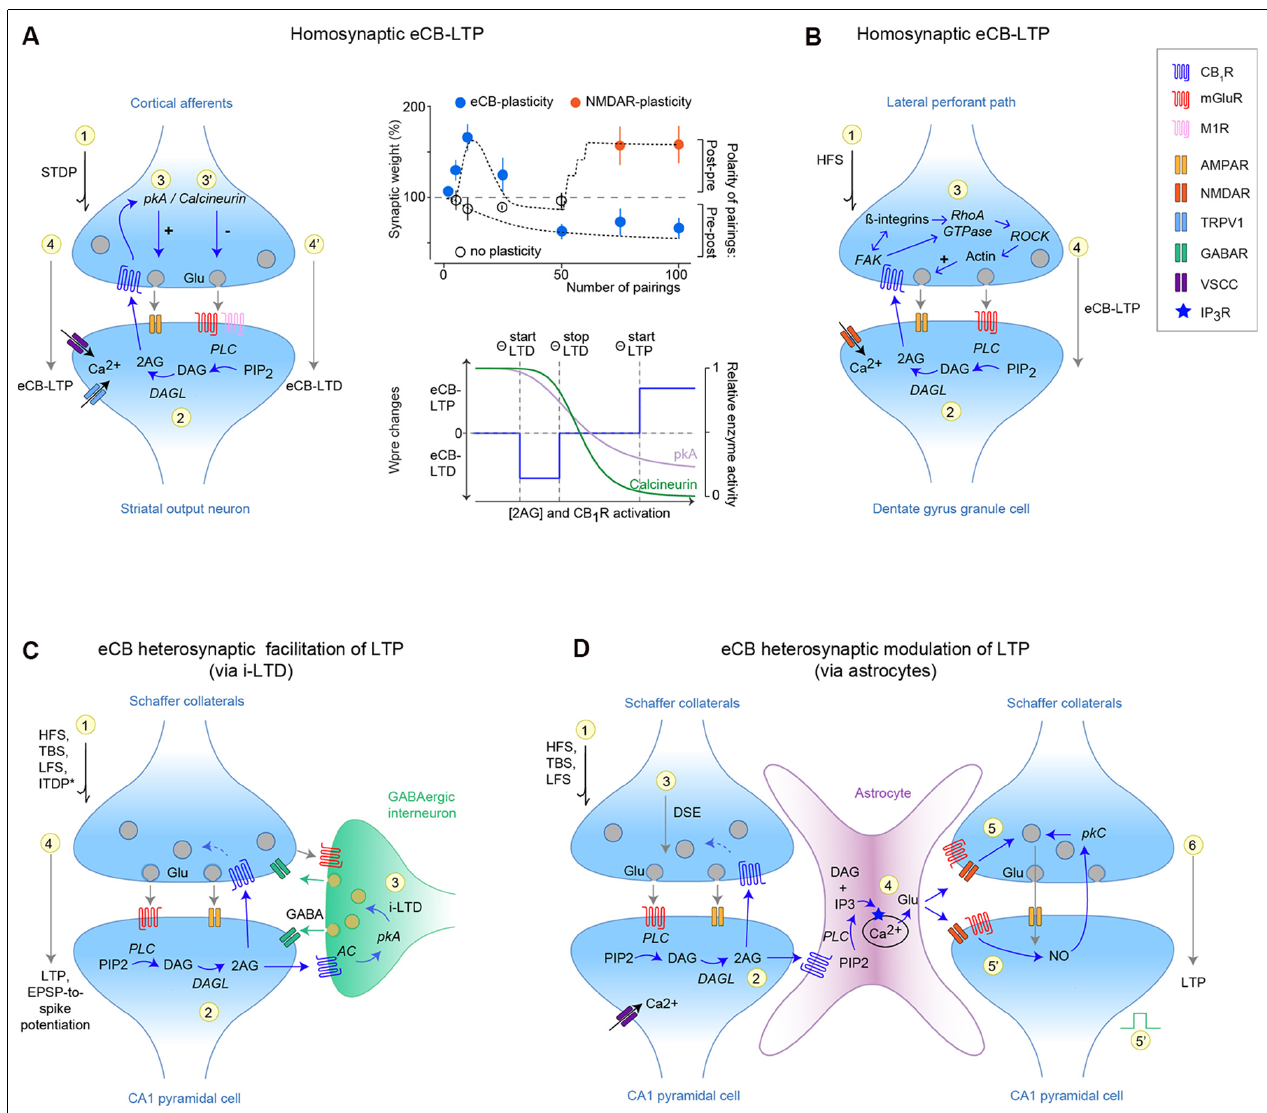
FIGURE 1 | Homosynaptic and heterosynaptic endocannabinoid (eCB)-mediated long-term potentiation (LTP). (A,B) Homosynaptic eCB-LTP in the striatum (A) and hippocampus (B) . (A) eCB-LTP is induced by few spike-timing-dependent plasticity (STDP) pairings ( ∼ 10–15 post-pre pairings), whereas eCB-LTD is induced by a larger number of pairings ( ∼ 50–100 pre-post pairings) at the same corticostriatal synapses (Cui et al., 2015, 2016, 2018a; Xu et al., 2018; Gangarossa et al., 2020). Right: top panel illustrates the domains of expression of eCB-LTP, eCB-LTD, and NMDAR-LTP related to the polarity and number of STDP pairings. Bottom panel: eCB-LTP and eCB-LTD are expressed depending on eCB levels [and cannabinoid type-1 receptor (CB 1 R) activation], such that low and high levels induced eCB-LTD and eCB-LTP, respectively. CB 1 R activation is expected to decrease pkA and calcineurin activity, via reduced calcium influx through voltage-sensitive calcium channels (VSCC). This effect is schematized by the relative protein kinase-A (pkA) and calcineurin activity changes upon increased CB 1 R activation, such that eCB-LTD occurs when calcineurin/ pkA > 1, whereas calcineurin/ pkA < 1 leads to eCB-LTP. (B) eCB-LTP at synapses between the lateral perforant path (LPP) and the hippocampal granular cells of the dentate gyrus, requires co-operative CB 1 R/ROCK signaling, which favors glutamate release via a presynaptic actin regulatory mechanism (Wang et al., 2016, 2018b). eCB-LTP illustrated in (A,B) are independent of the GABAergic transmission and astrocytic calcium transients, present a presynaptic locus of expression and hence rely on a homosynaptic mechanism. (C,D) Heterosynaptic eCB-LTP involving intermediary elements such as GABAergic interneurons (C) and astrocytes (D) . (C) Heterosynaptic eCB-LTP at CA3–CA1 hippocampal synapses. Activation of mGluR1/5 promotes 2-AG synthesis and release; 2-AG activates CB 1 R located on neighboring GABAergic interneurons and induces LTD via a pkA-dependent mechanism. This LTD of inhibitory transmission (i-LTD) then facilitates the release of glutamate at CA3–CA1 synapses promoting a local LTP. This eCB-mediated metaplasticity can be induced with various cell conditioning paradigms, and most notably subthreshold stimulations (HFS, LFS, TBS or ITDP; Chevaleyre and Castillo, 2003, 2004; Zhu and Lovinger, 2007; Lin et al., 2011; Pan et al., 2011; Xu et al., 2012; Basu et al., 2013; Orr et al., 2014; Monory et al., 2015; Silva-Cruz et al., 2017; Kim et al., 2019). (D) Heterosynaptic eCB-LTP involving astrocytes at CA3–CA1 synapses. Neuronal activity (HFS, TBS, LFS) induces synthesis of eCBs at synapse-1 which activate astrocytic CB 1 R. Then, astrocytic glutamate release ( via IP 3 -induced calcium-release mechanism) induces an NMDAR-facilitation or NO-mediated LTP on neighboring CA1 synapse-2. This eCB-mediated lateral synaptic regulation has been observed in the hippocampus (Navarrete and Araque, 2008, 2010; Gómez-Gonzalo et al., 2015; Covelo and Araque, 2016) and striatum (Martín et al., 2015).